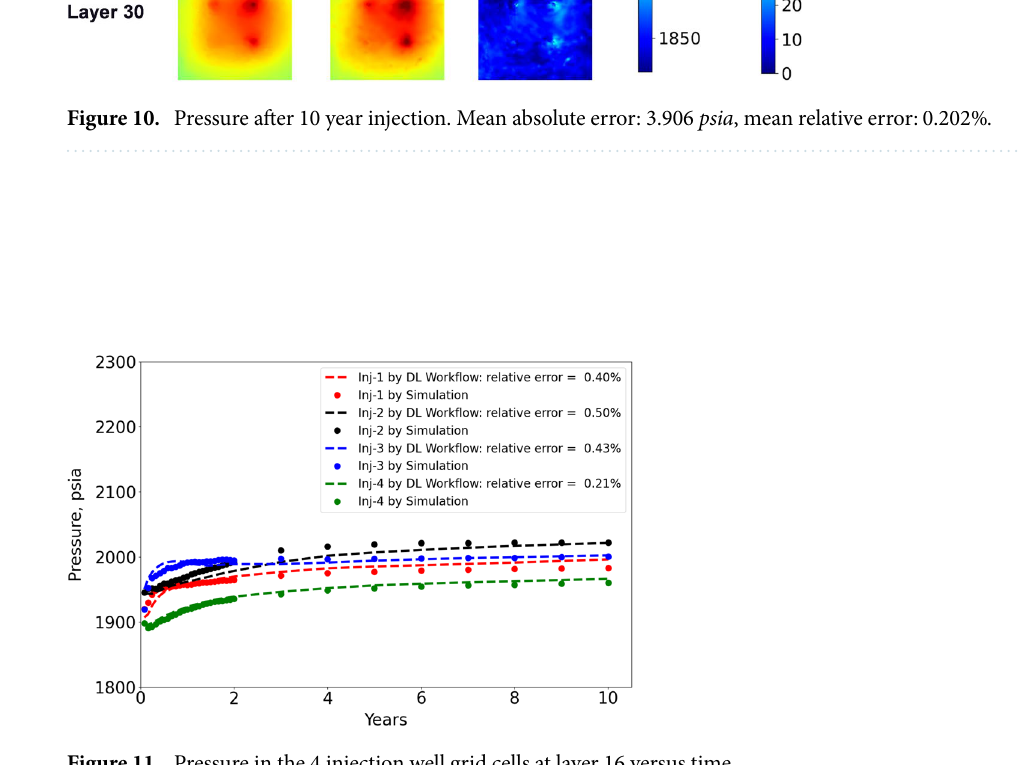
Figure 11. Pressure in the 4 injection well grid cells at layer 16 versus